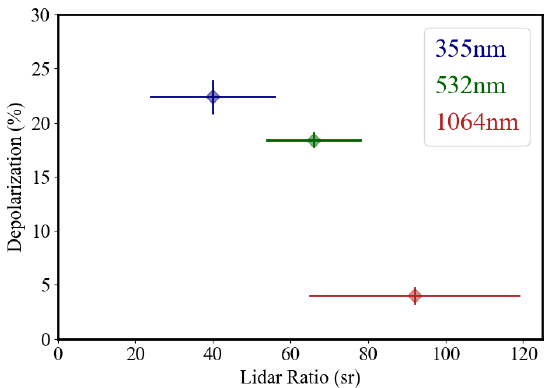
Fig.2 Intensive optical properties of the stratospheric smoke particles at 355, 532 and 1064 nm. All values correspond to the time window 22/8 20:45 – 23:15 UTC, except of the PLDR at 1064 nm which corresponds to the time window 23:50 – 00:30 UTC.